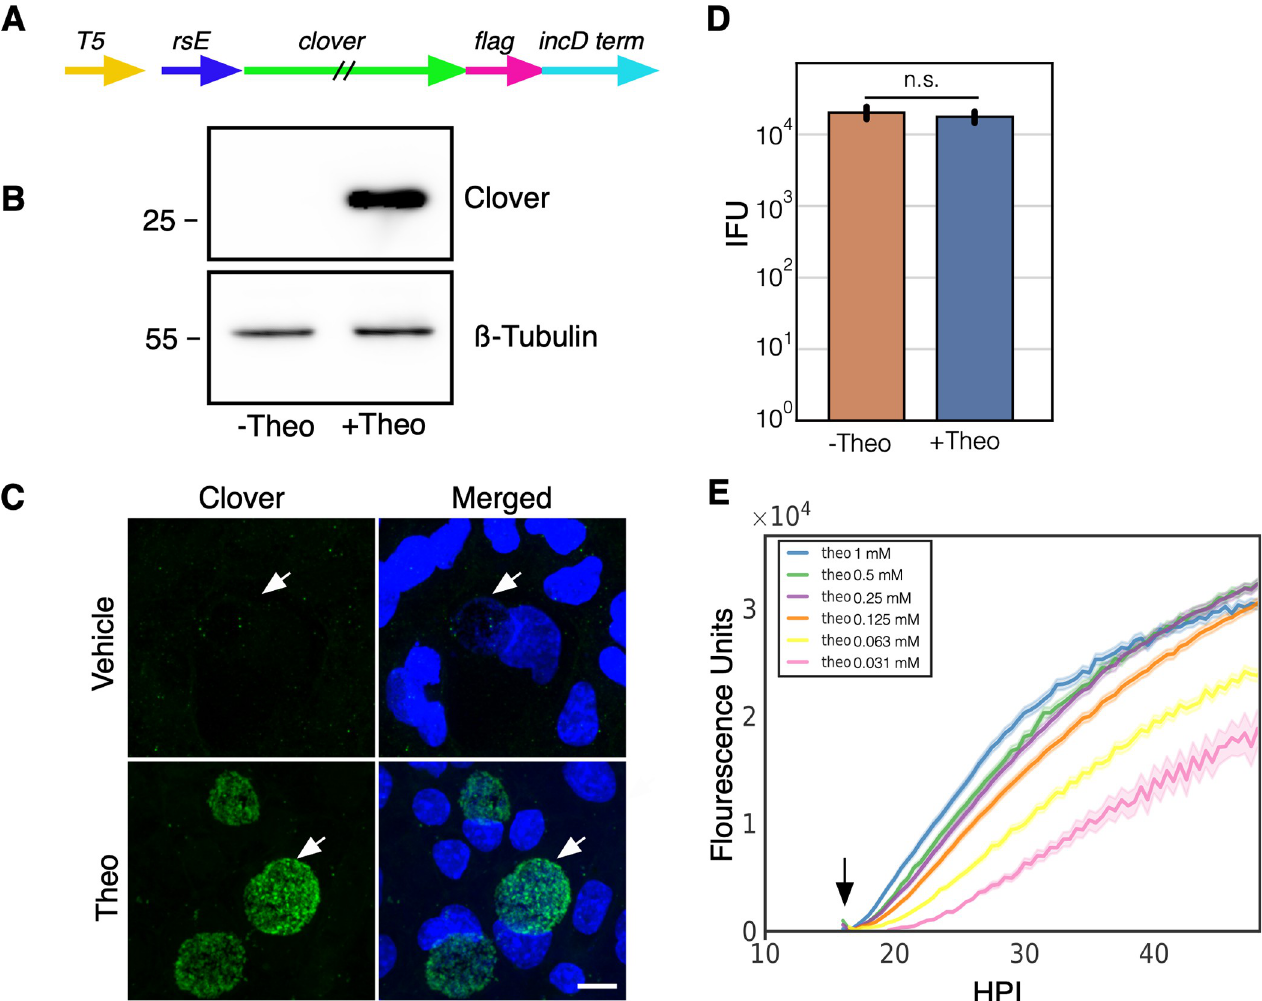
Fig 1. Characterization of p2TK2-SW2-T5-E-clover-flag. A) Schematic of the E-clover expression construct consisting of the T5-lac promoter (T5), riboE riboswitch (rsE) and the ORF for the clover fluorescent protein with an inframe 3x flag tag. B) Anti-flag western blot of Cos-7 cells infected with L2-T5-E- clover-flag comparing expression of theophylline treated and untreated cultures. Cells were induced or not with 0.5 mM theophylline at 16 hpi and proteins were harvested at 30 hpi. A ß-tubulin I western blot served as a sample loading control. C) Confocal micrographs of Cos-7 cells infected with L2-T5-E-clover- flag and induced or not with 0.5 mM theophylline at 16 hpi and fixed and stained with DAPI for microscopy at 30 hpi. DAPI (blue), Clover (green). Arrow indicates the position of the chlamydial inclusion. Size bar = 10 μ m. D) Cos-7 cells were infected with L2-T5-E-clover-flag and the production of infectious progeny was determined at 48 hpi after 0.5 mM theophylline induction or vehicle only. E) Cos-7 cells were infected with L2-T5-E-clover-flag, treated with varying dilutions of theophylline at 16 hpi (1 mM, 0.5 mM, 0.25 mM, 0.125 mM, 0.0625 mM, 0.03125mM) and imaged for 50 hours using live cell imaging. The Clover expression intensities from > 50 individual inclusions were monitored via automated live-cell fluorescence microscopy and average intensities were plotted. Live cell imaging demonstrated that Clover induction was dose responsive. Cloud represents SEM. Y-axes are denoted in scientific notation. Error bars = SEM. n. s. denotes p-values >